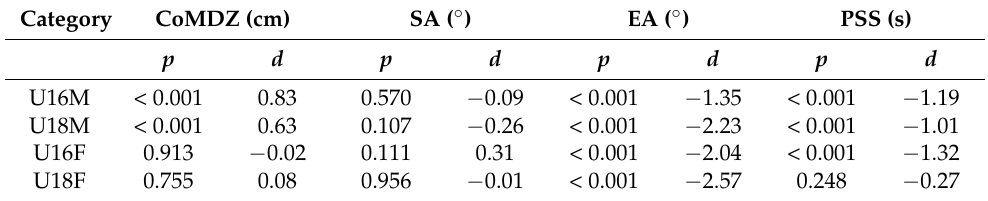
Table 3. Differences in kinematic variables between 2-pt and 3-pt shooting in individual categories.